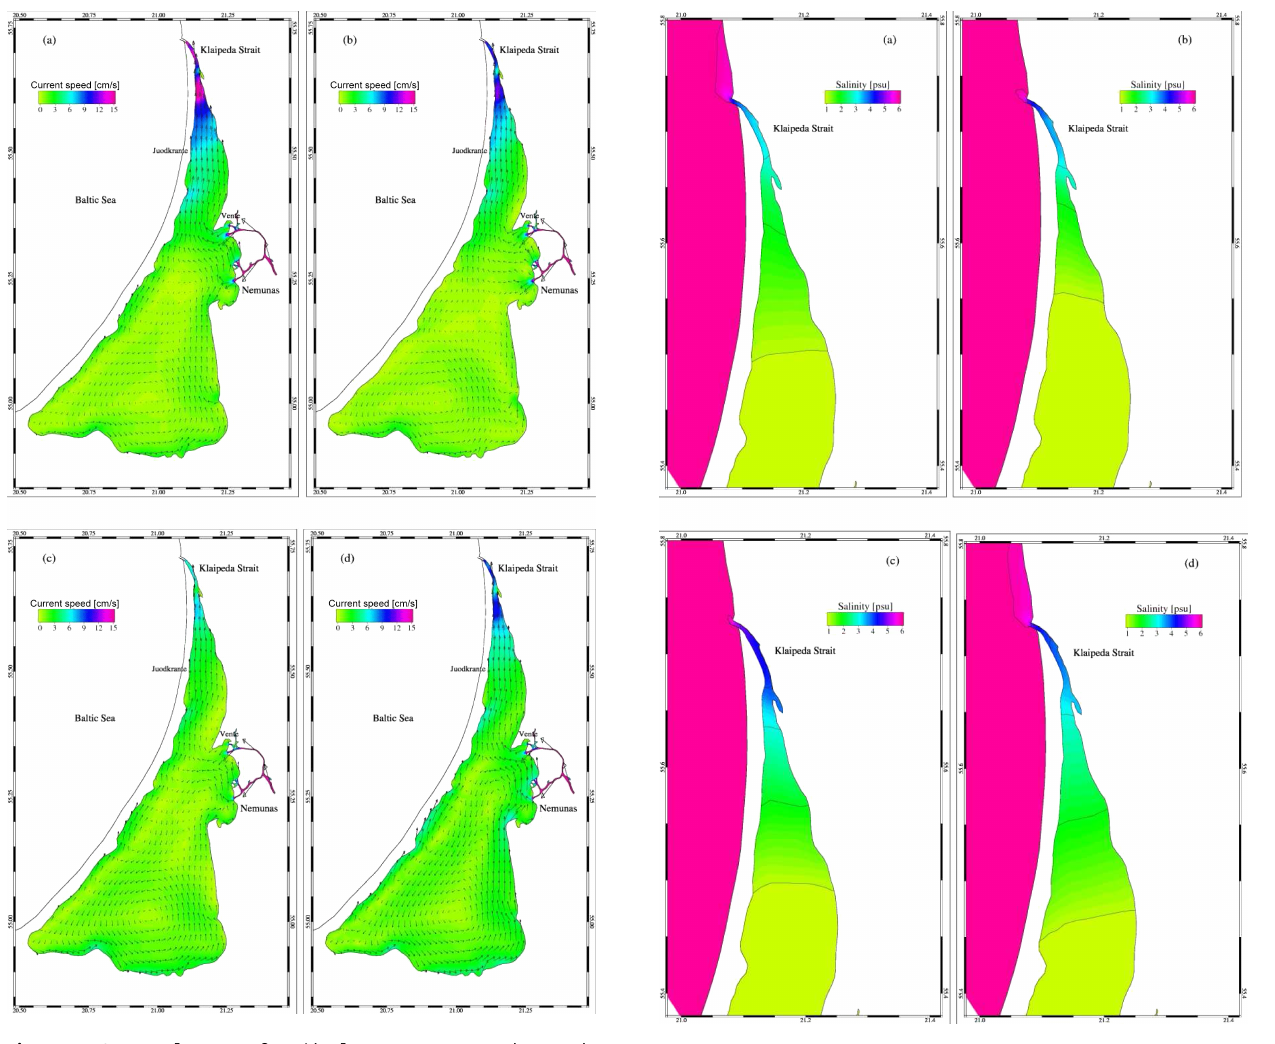
Figure 6. Seasonal maps of salinity distribution averaged over the years 2004–2014. Maps show winter (a) , spring (b) , summer (c) , and autumn (d) . Only the area of the Klaip˙eda Strait is shown. The southernmost isoline in the figures always indicates